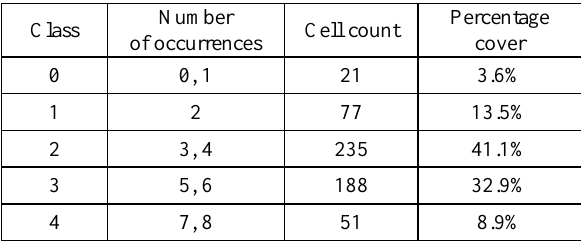
Table 3. Classification of occurrence map: cell count and percentage cover for the five classes.